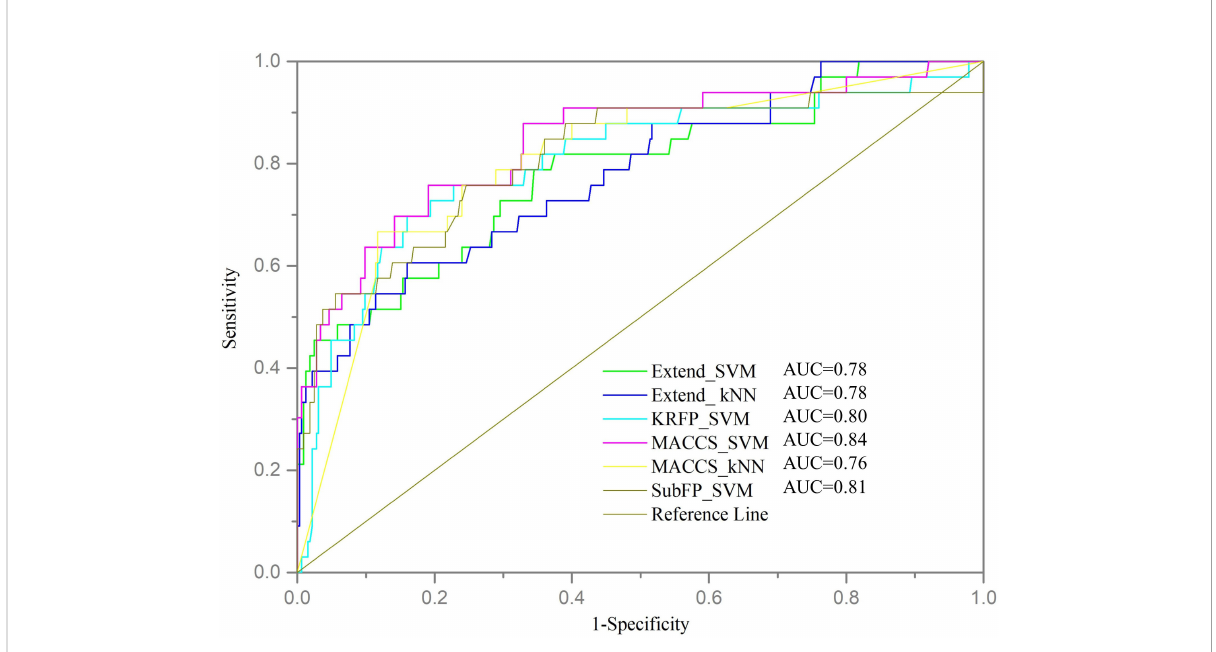
FIGURE 2 ROC curve of models on validation set. Each color line represents a